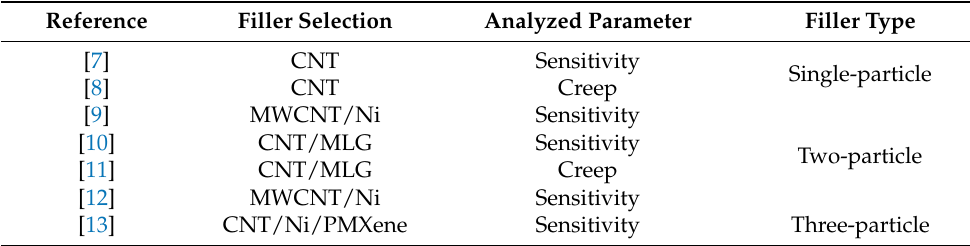
Table 1. Previous work to improve sensor